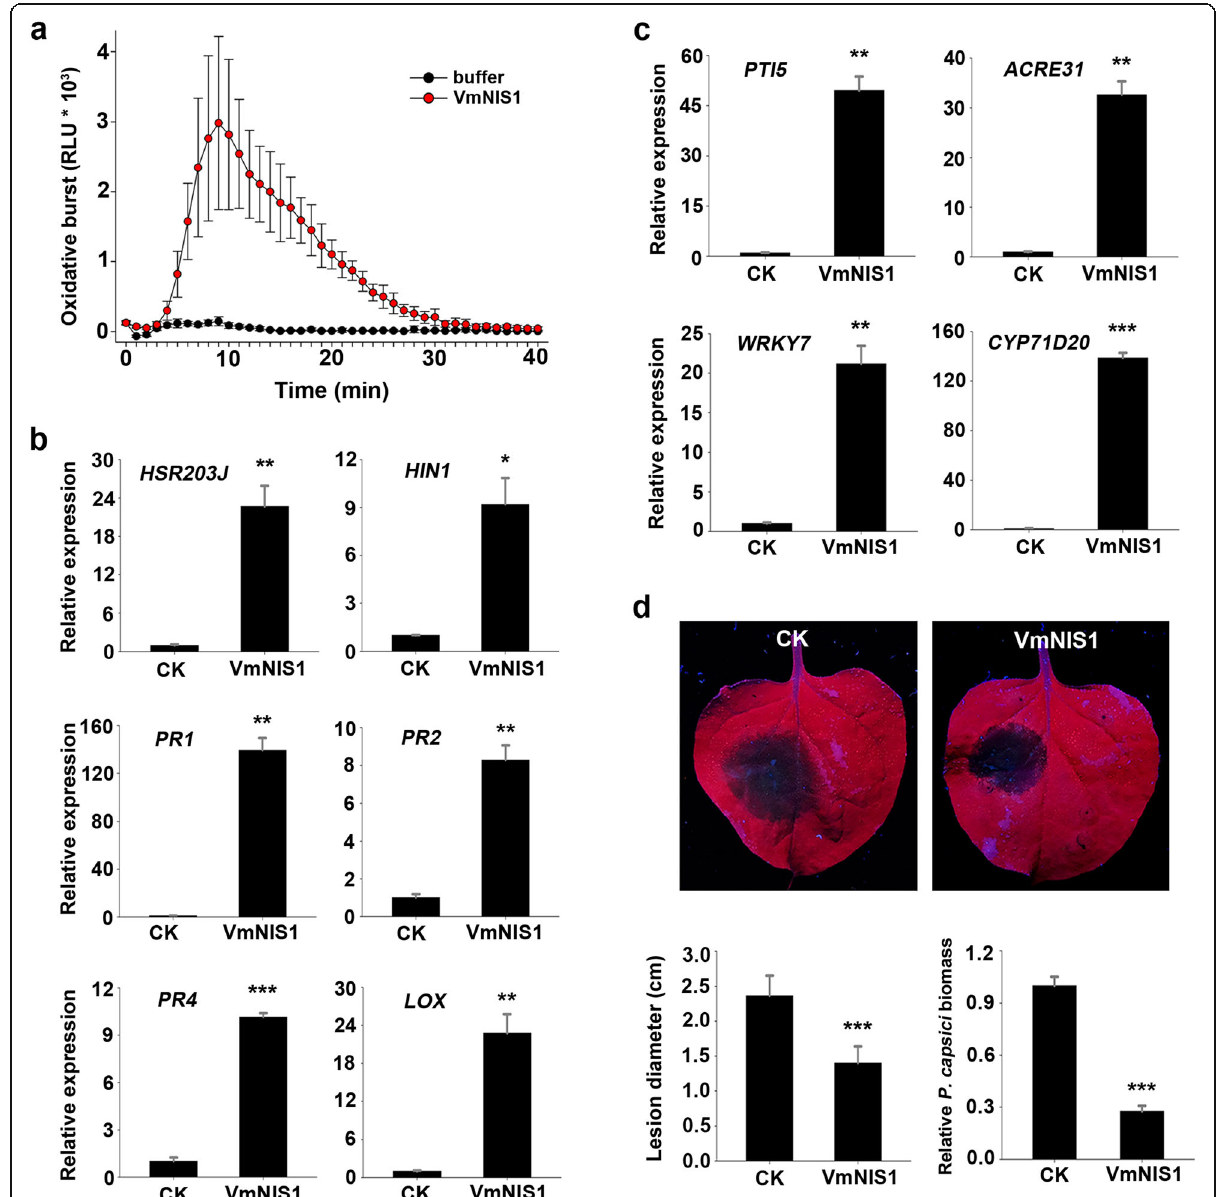
Fig. 3 VmNIS1 triggers immune responses in N. benthamiana . a. Oxidative burst in N. benthamiana leaves triggered by purified VmNIS1 protein. ROS production represented by relative luminescence units (RLU) was measured through treatment with 1 μ M purified VmNIS1 protein. b. Transcript accumulation of HSR203J , HIN1 , PR1 , PR2 , PR4 and LOX in N. benthamiana leaves treated with 1 μ M purified VmNIS1 protein for 6 h. Transcript levels of tested genes were determined by RT-qPCR, with NbActin serving as the internal reference. Values represent the means ± SD of three biological replicates. Differences were assessed by Student ’ s t -test. *, P < 0.05; **, P < 0.01; ***, P < 0.001. c. Transcript accumulation of PTI marker genes PTI5 , ACRE31 , WRKY7 and CYP71D20 in N. benthamiana leaves treated with 1 μ M purified VmNIS1 protein for 6 h. Transcript levels of these genes were determined by RT-qPCR. NbActin was used as the internal reference. Values represent the means ± SD of three biological replicates. Differences were assessed by Student ’ s t -test. **, P < 0.01; ***, P < 0.001. d. VmNIS1 protein treatment enhanced N. benthamiana resistance against Phytophthora capsici . N. benthamiana leaves were pretreated with 1 μ M purified VmNIS1 protein for 12 h before inoculation of P. capsici . Representative leaves showing disease lesions were taken 36 h post inoculation under a UV light. Lesion diameters were calculated from six biological replicates. Relative biomass showing the ratios of P. capsici to N. benthamiana DNA was determined by RT-qPCR. Values represent the means ± SD. Differences were assessed by Student ’ s t -test. ***, P <